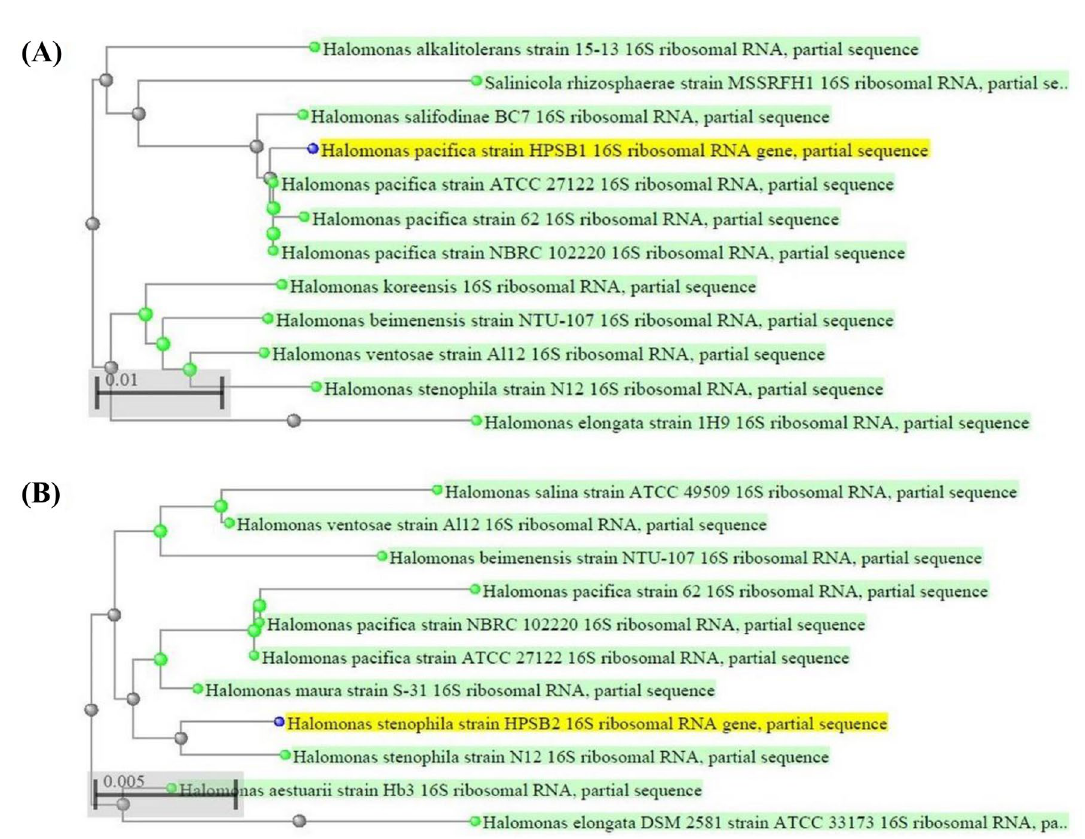
Figure 9. Phylogenetic dendrograms, based on partial 16S rRNA nucleotide sequences, showing the relationship between the selected halophilic bacterial strains HPSB1 and HPSB2 with closely related taxa of (A) H. pacifica and (B) H. stenophila , respectively. The blast names color map in green dots and label represents the related strains as g-proteobacteria while blue dots in yellow label represents the unknown query